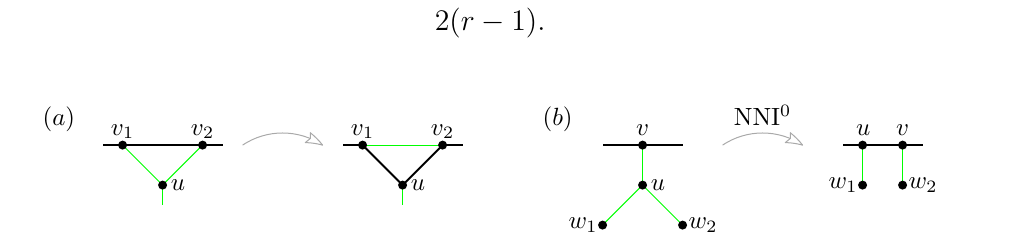
Figure 11: Transformation and NNI 0 used in Step 1 to obtain a tree-based network N